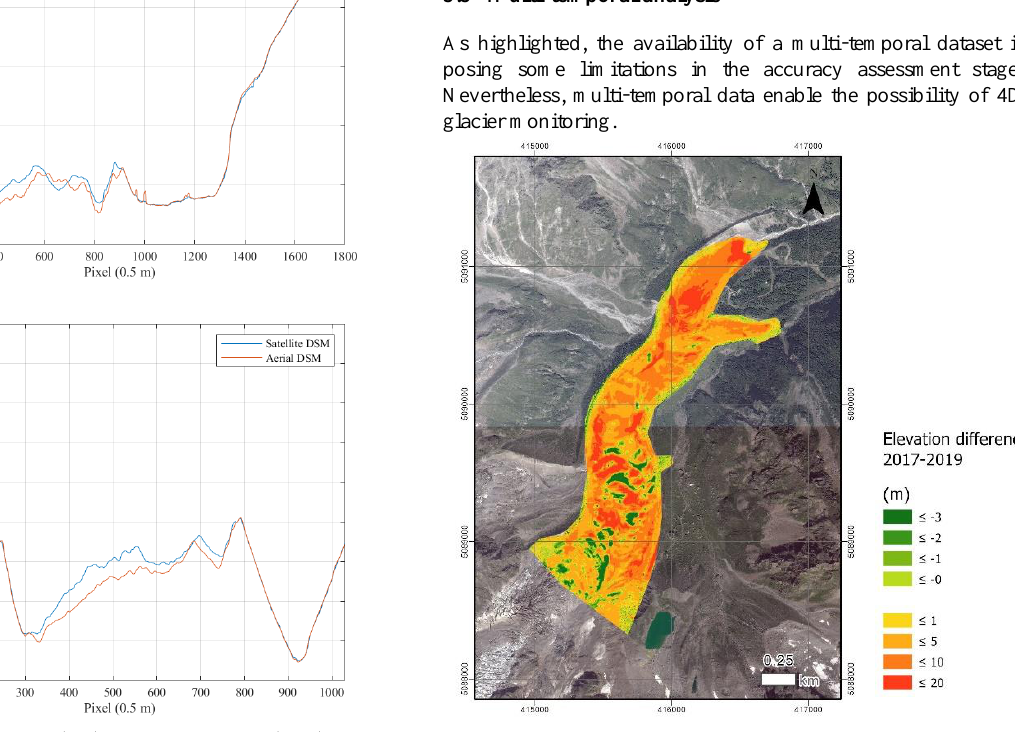
Figure 15. Elevation differences in the period 2017-2019 over the Belvedere glacier ablative